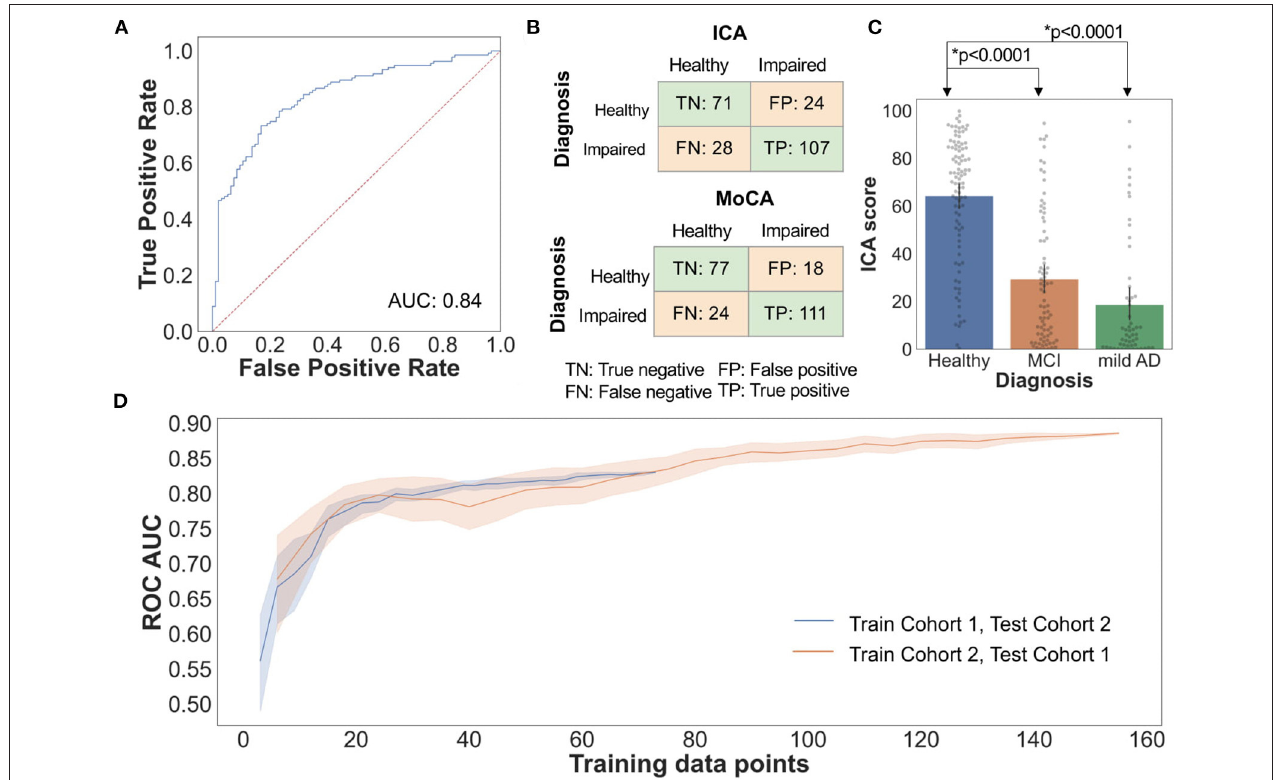
FIGURE 4 | (A) Healthy vs. Impaired ROC: AI classification performance by LOOCV (B) The confusion matrix for the ICA and MoCA, comparing the prediction of the cognitive tests with clinical diagnosis. (C) Bar plot with 95% confidence interval of ICA Score for healthy, MCI, and mild AD, with all data points overlaid on the graph. t test p -value comparing Healthy-MCI, and healthy–mild AD ICA score is also shown (D) ROC AUC vs. training data size. The shaded area represents 95% CI as each training subset was selected randomly 20 times from the whole study data.